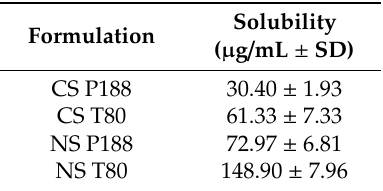
Table 2. Water solubility of DCF coarse suspensions (CS P188, CS T80) and nanosuspensions (NS P188 and NS T80) at 37 ◦